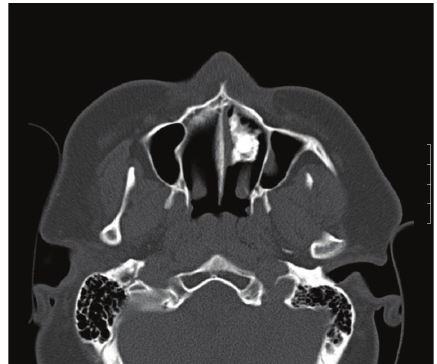
Figure 2: CT showing rhinolith.